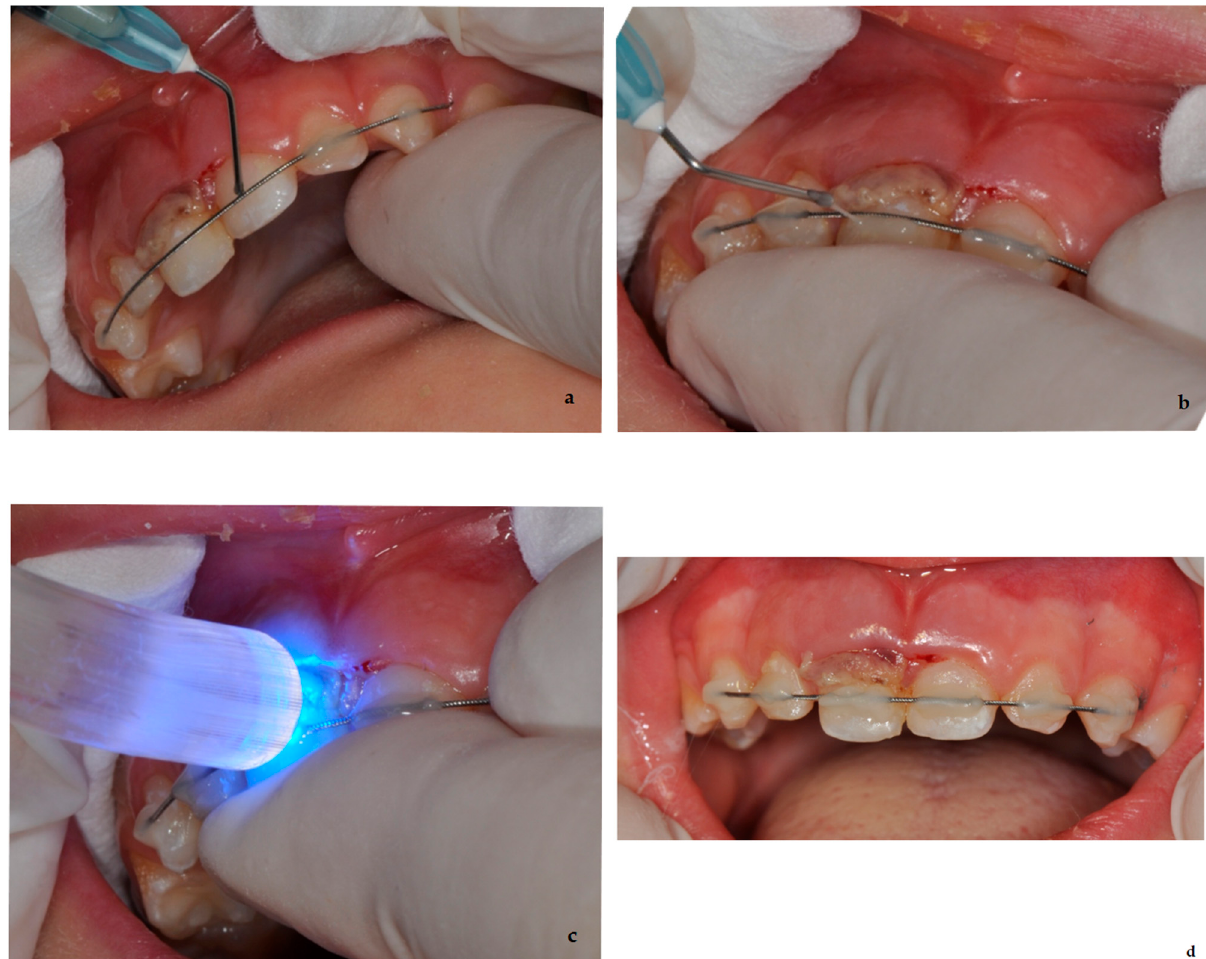
Figure 2. Different steps of the performed treatment: ( a ) preparation of the splint on the adjacent teeth; ( b ) gentle reposition of the element 5.1; ( c , d ) stabilization of the tooth through the splint.